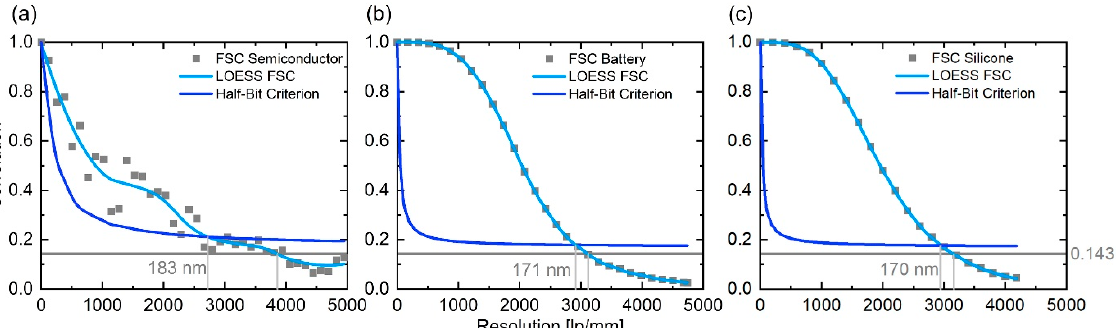
Figure 5. FSC curves of the three samples shown below, ( a ) the semiconductor memory, ( b ) the lithium battery and ( c ) the conductive elastomer, and the corresponding half-bit criterion curves plotted versus spatial resolution. The FSC data were smoothed with a LOESS algorithm. The intersection points between both curves are shown in each case. Additionally, the less valid 1/7 level is plotted. The achieved resolutions are in the range of 170–185 nm and thus confirm the determined 2D resolution.